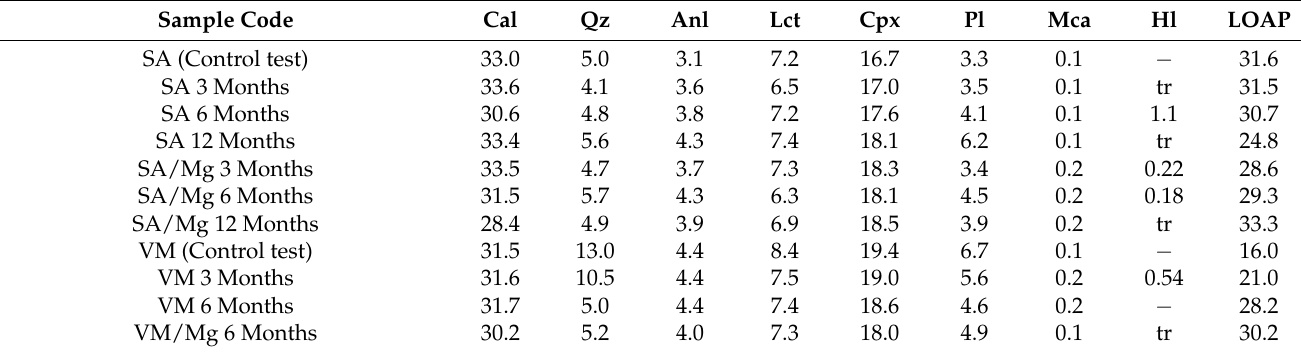
Table 5. Results of quantitative X-ray